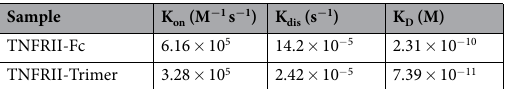
Table 2. Assessment of kinetic rate constants for binding to TNF- α by